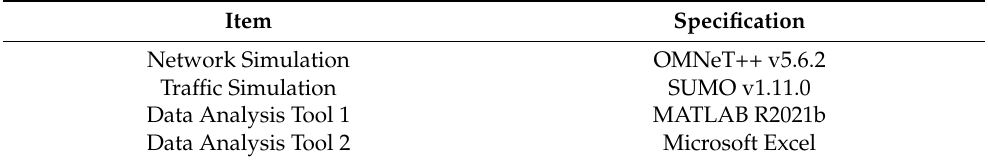
Table 6. Software